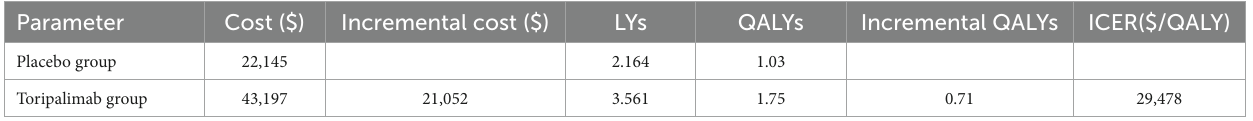
TABLE 2 Base-case results. Parameter